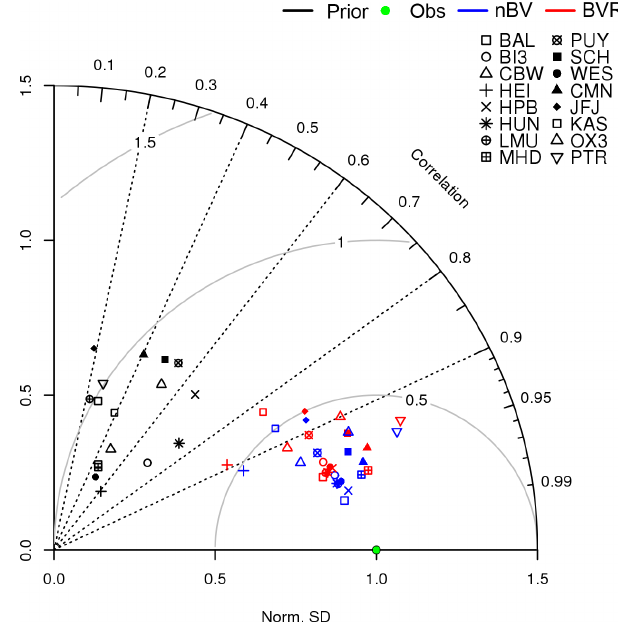
Figure 2. Taylor diagram for modeled and observed time series of CO 2 dry mole fractions. Prior (black), observed (green, the perfect match of modeled and observed time series) and the different in- version cases (nBV is blue; BVR is red) are displayed. Different symbols denote different atmospheric stations. The normalized SD was calculated as the ratio of the SD of the modeled time series to the SD of observations. Gray semicircles show contours of the SD of the model